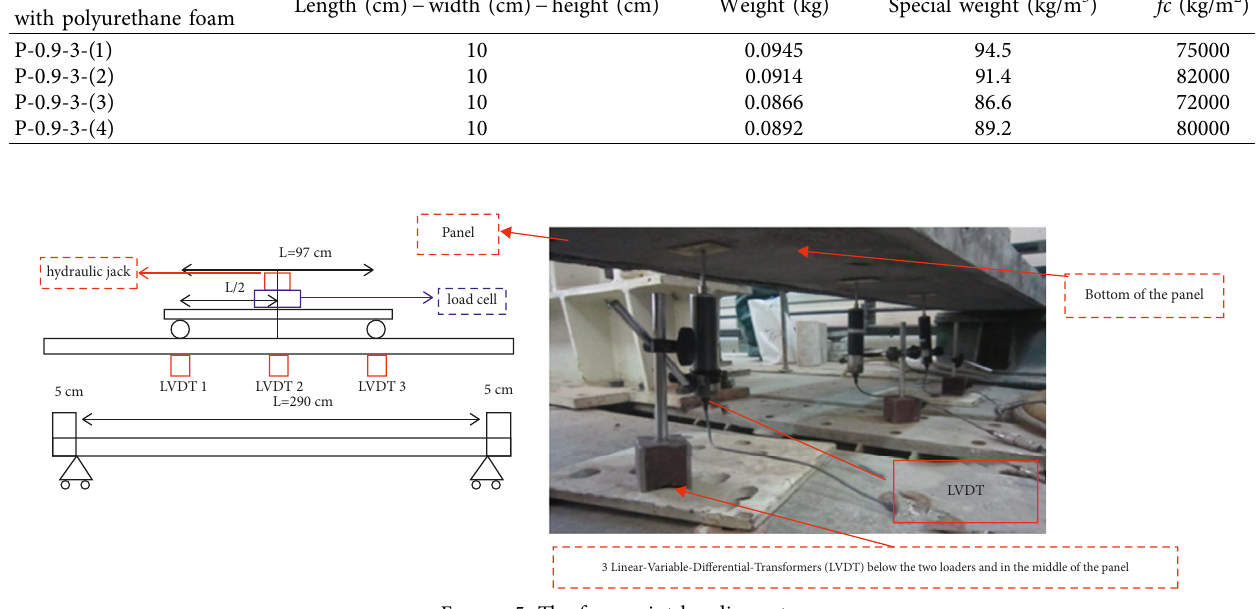
Figure 5: The four-point bending set-up.